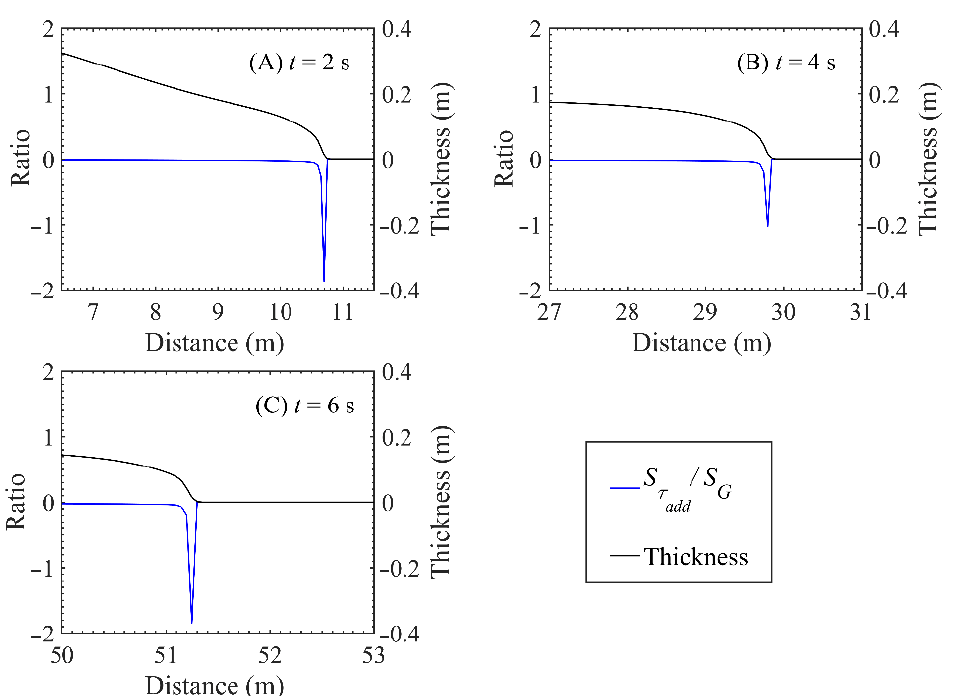
Figure 4. The ratios of the additional shear stress to the gravitational term along with the flow thicknesses at several instants. ( A ) t = 2 s; ( B ) t = 4 s; ( C ) t = 6 s.